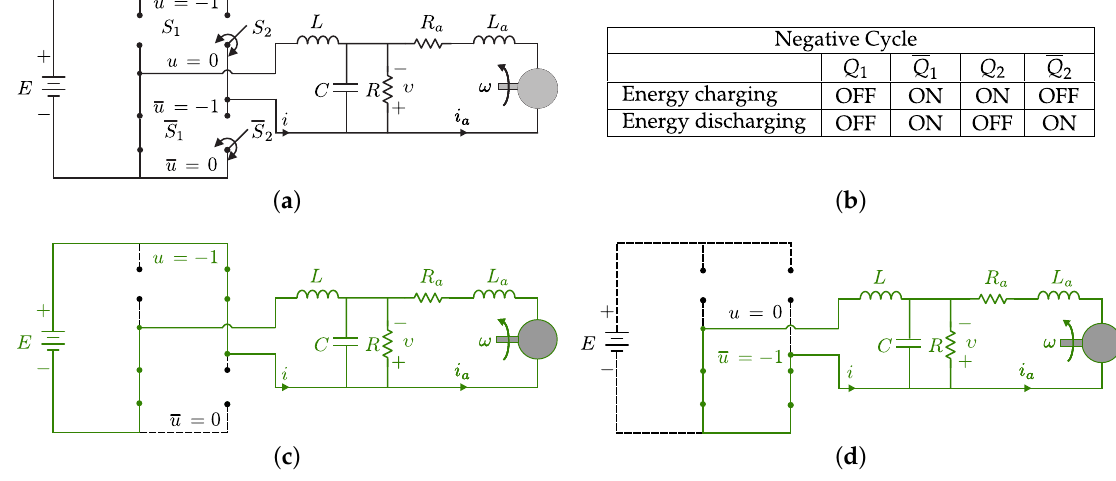
Figure 3. The full-bridge Buck inverter–DC motor system: ( a ) ideal circuit for negative cycle; ( b ) in negative cycle Q 2 and Q 2 of Figure 1 operate as a transistor and as a diode, respectively; ( c ) energy charging mode of operation; and ( d ) energy discharging mode of